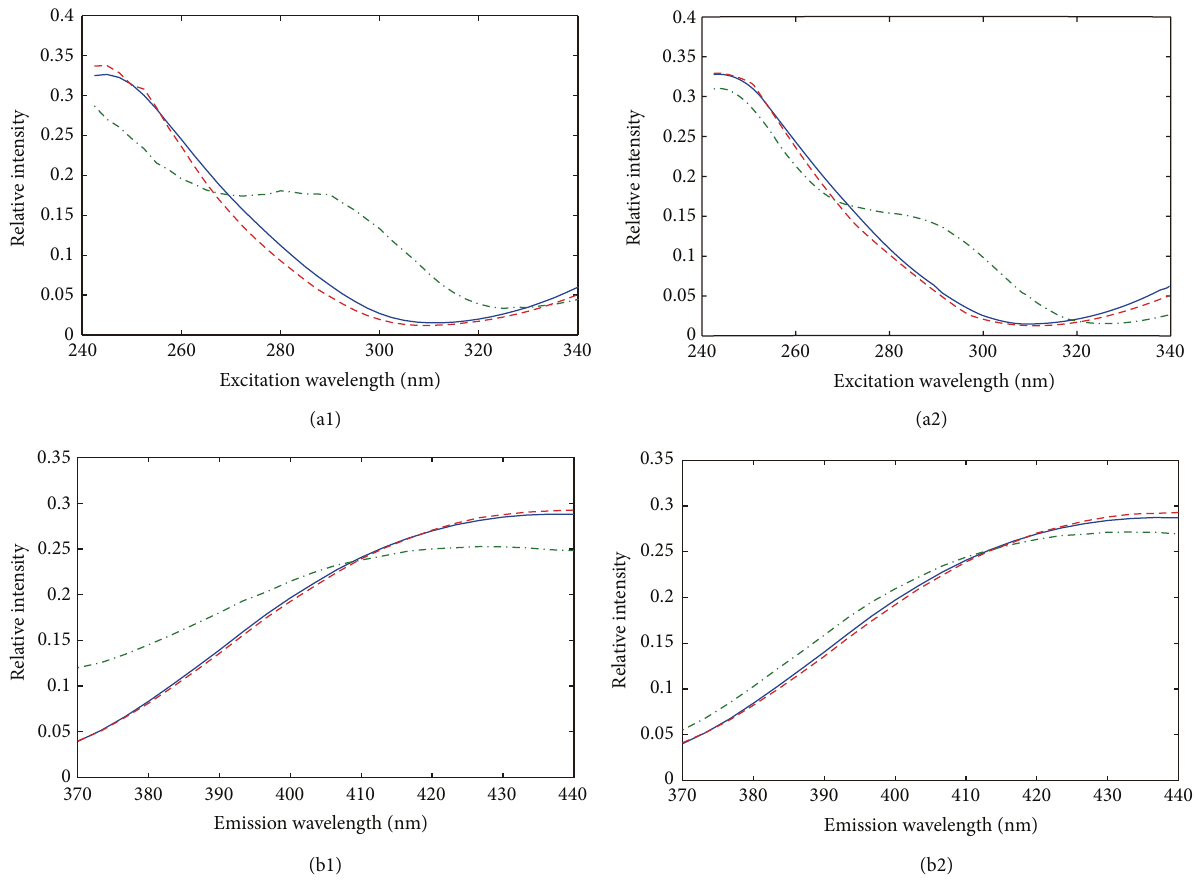
Figure 5: Actual and resolved excitation spectra (a1) and emission spectra (b1) of 78 amlodipine besylate in human plasma using PARAFAC, and actual and resolved excitation spectra (a2) and emission spectra (b2) of valsartan in human plasma using ATLD. The solid lines, dotted solid lines, and dotted lines represented the loadings of amlodipine besylate, loadings for an inherent interference from the human plasma, and the actual spectral profiles of amlodipine besylate, respectively.